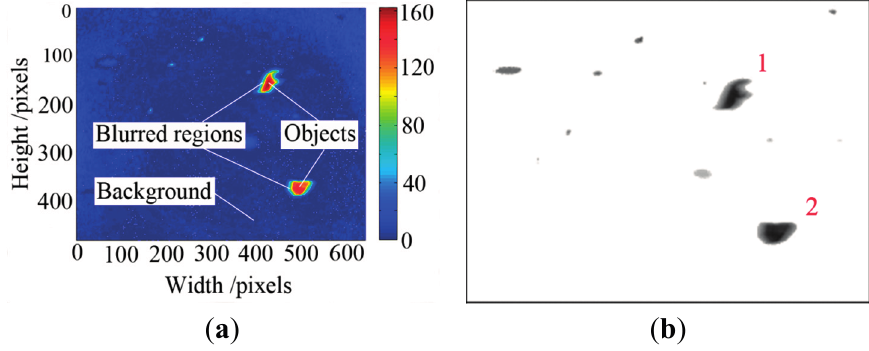
Figure 7. Difference and segmentation result of particle image: ( a ) pixel value of difference image; and ( b ) target debris